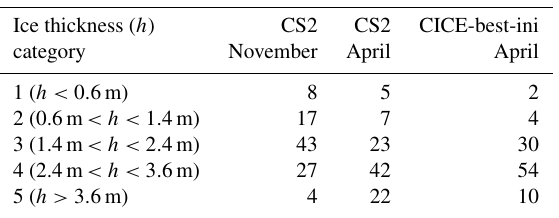
Table 4. Mean area fraction of sea ice per category in % according to CS2 and CICE-best-ini (over the region shown in Fig. 3 and for the period 2010 to